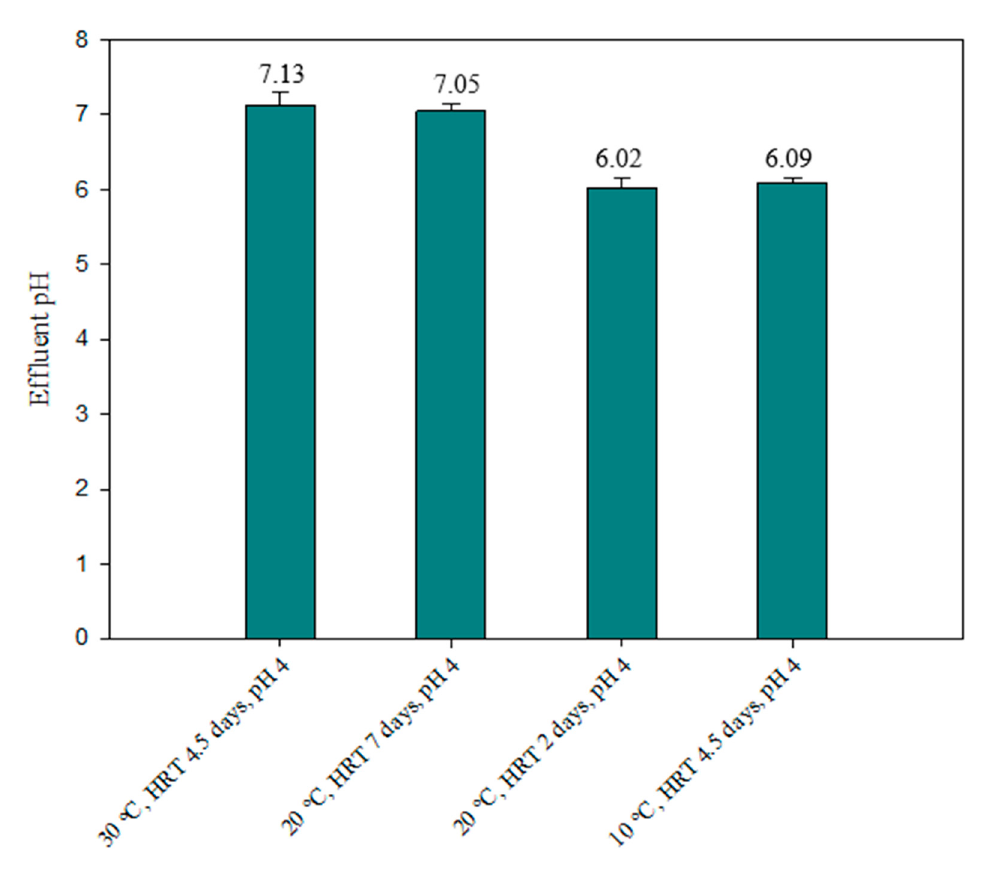
Figure 6. Average effluent pH at different conditions with an influent pH of 4.